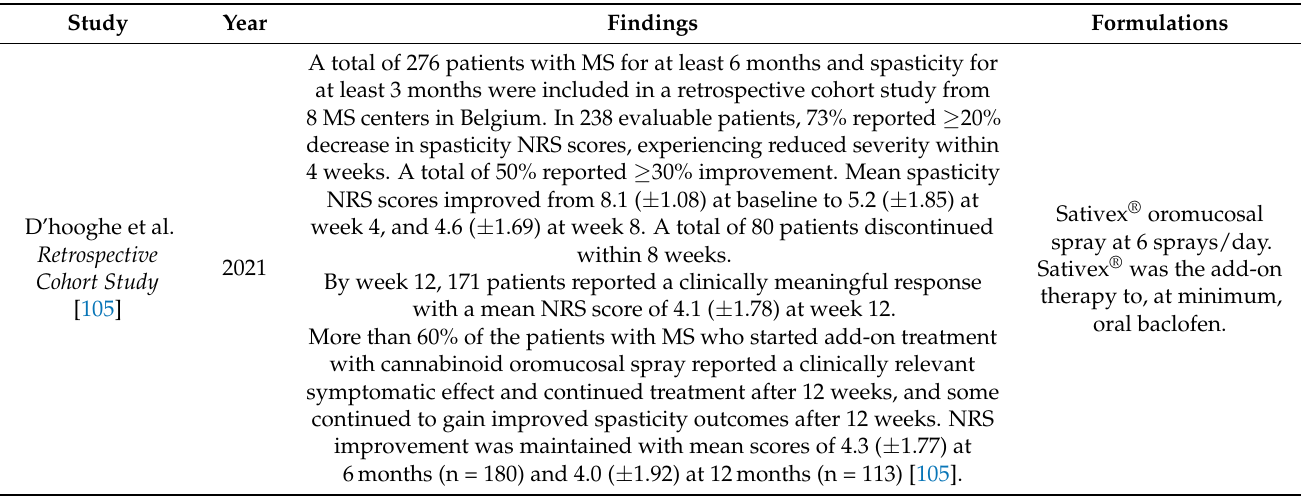
Table 1. Effects of cannabinoids on spasticity in multiple